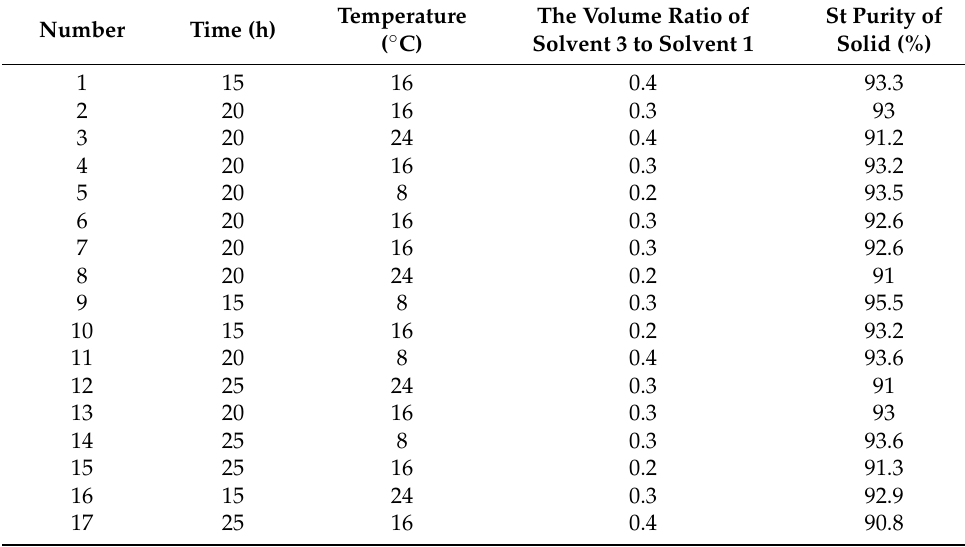
Table 4. Test design table and test results of response surface